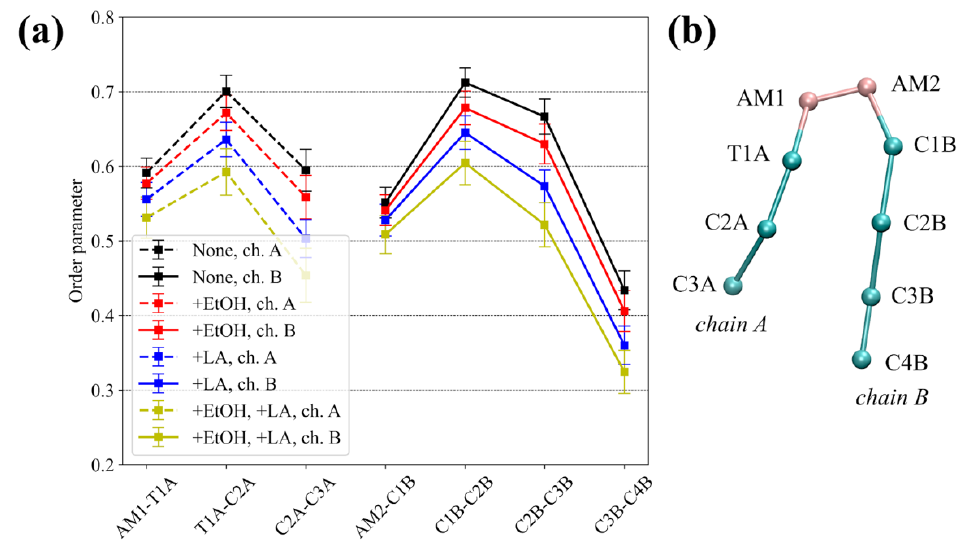
Figure 3. ( a ) Order parameter of the hydrocarbon tails of sphingosine (chain A) and the fatty acid